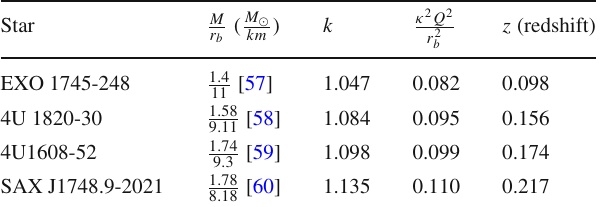
Table 1 The dimensionless parameter k , the charge-radius ratio κ 2 Q 2 and the surface redshift z obtained by using the observational mass M and the radius r b for some neutron stars Star M